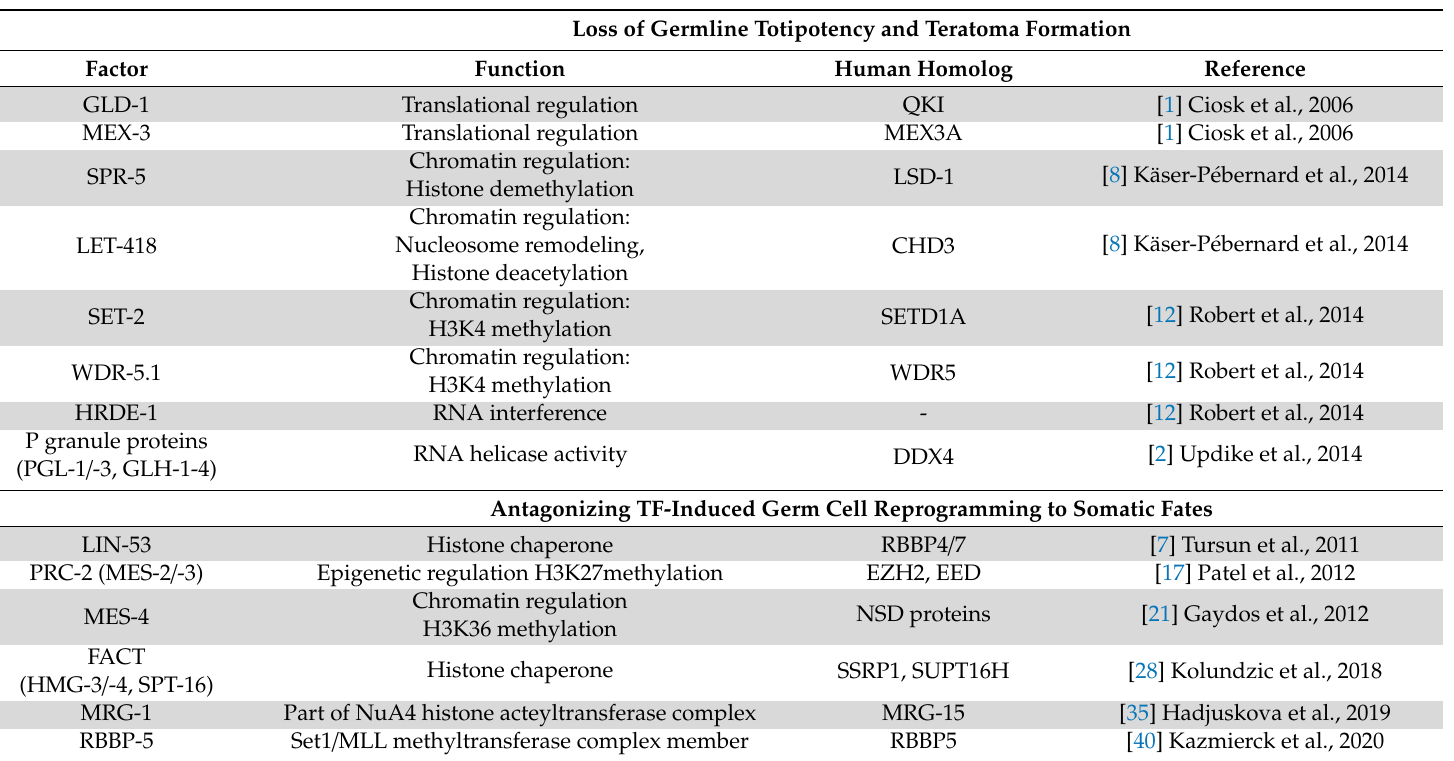
Table 1. Overview of Safeguarding